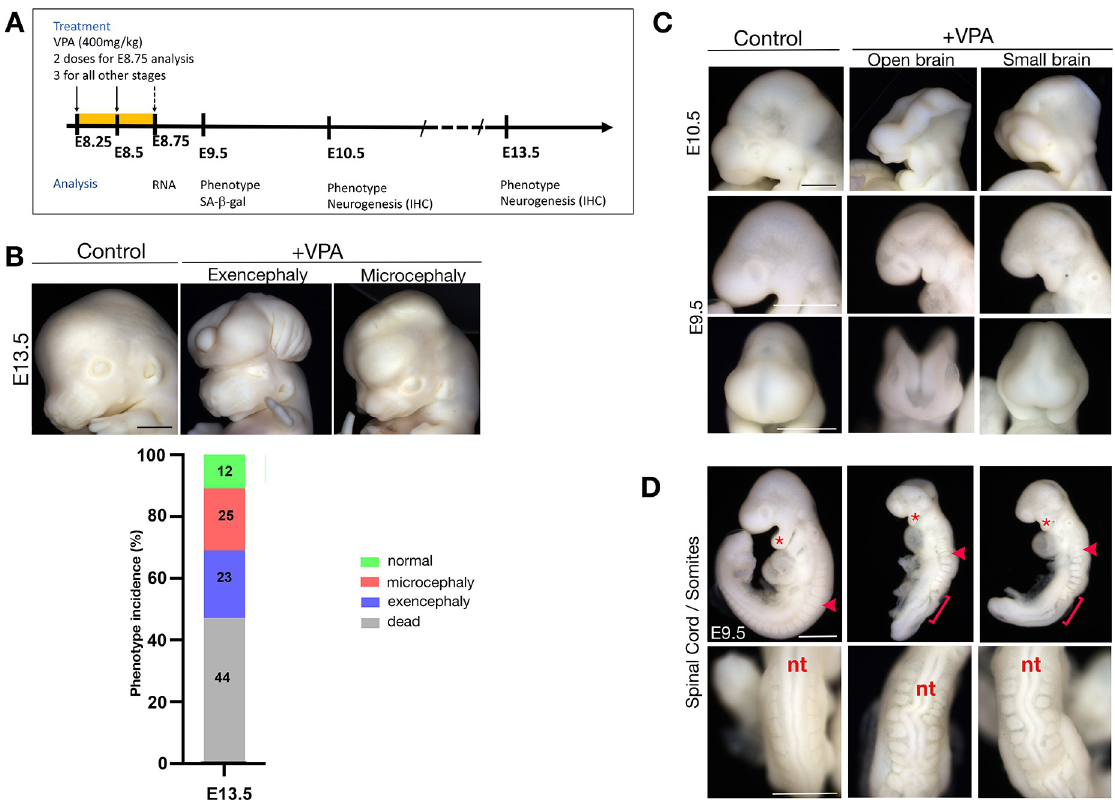
Fig 1. VPA treatment induces developmental defects, including exencephaly, microcephaly, and abnormal spinal cord development. (A) Schematic of experimental treatment of mice with VPA and timeline of analysis. (B) Top: embryonic head phenotypes in CD1 mice at E13.5 resulting from VPA exposure. Scale bar, 1 mm. Bottom: phenotype incidence at E13.5 ( n = 45 embryos from 4 litters). (C) Embryonic head phenotypes in CD1 mice at E10.5 and E9.5. Scale bar, 500 μ m. (D) Lateral views (top) and dorsal views (bottom) of control and VPA- treated embryos dissected at E9.5, illustrating the pronounced curve in the nt and abnormally shaped somites observed (arrowhead and brackets), and hypoplastic pharyngeal arches (asterisks). Scale bar, 500 μ m. E, embryonic day; IHC, Immunohistochemistry; nt, neural tube; VPA, valproic